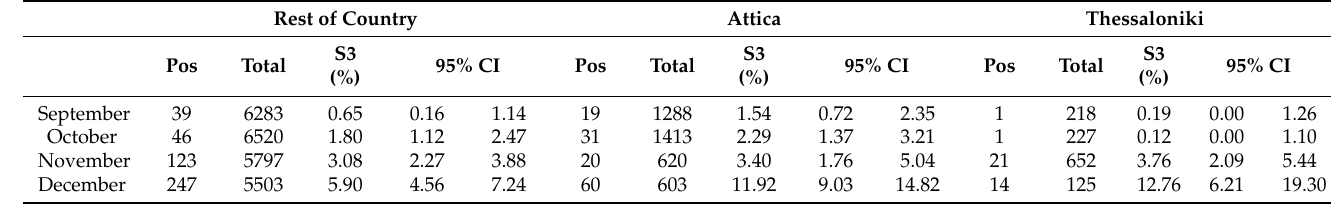
Table 3. Monthly seropositivity (S3) in the Regional Units of Attica and Thessaloniki compared to the rest of the